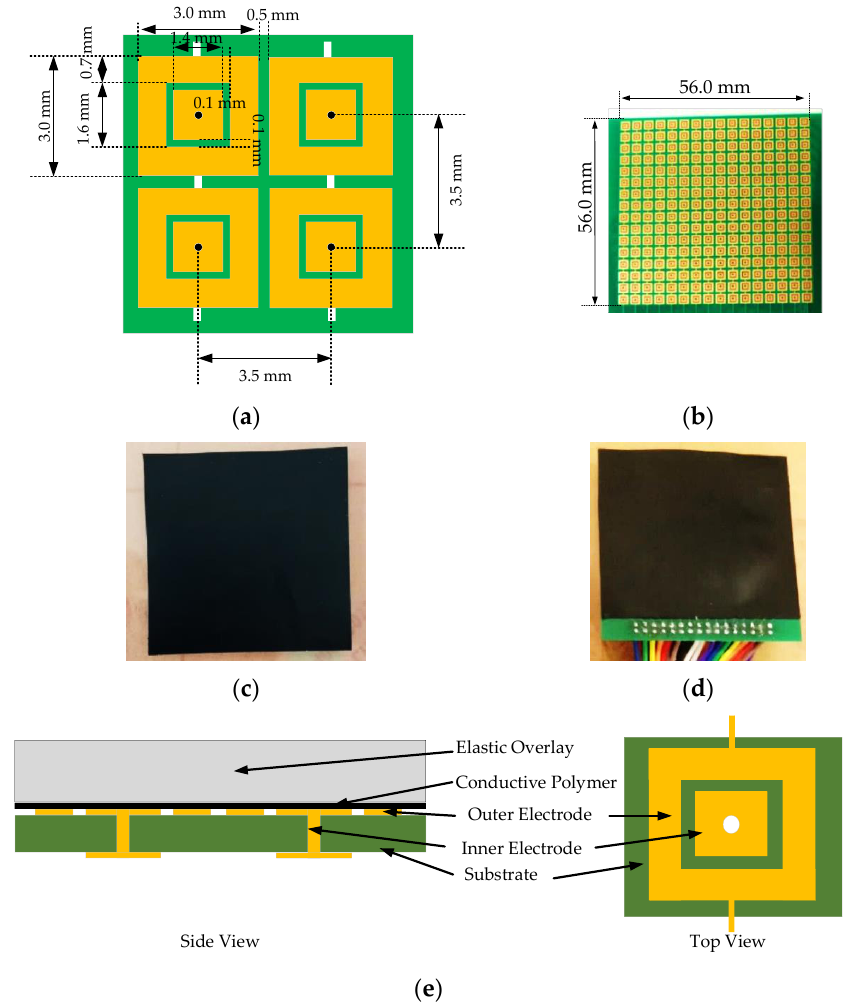
Figure 6. The sensor used in this research: ( a ) the size of sensor electrode; ( b ) the designed electrode and size of sensor array; ( c ) the conductive polymer sheet; ( d ) the actual sensor assembly; ( e ) layers of the sensor.